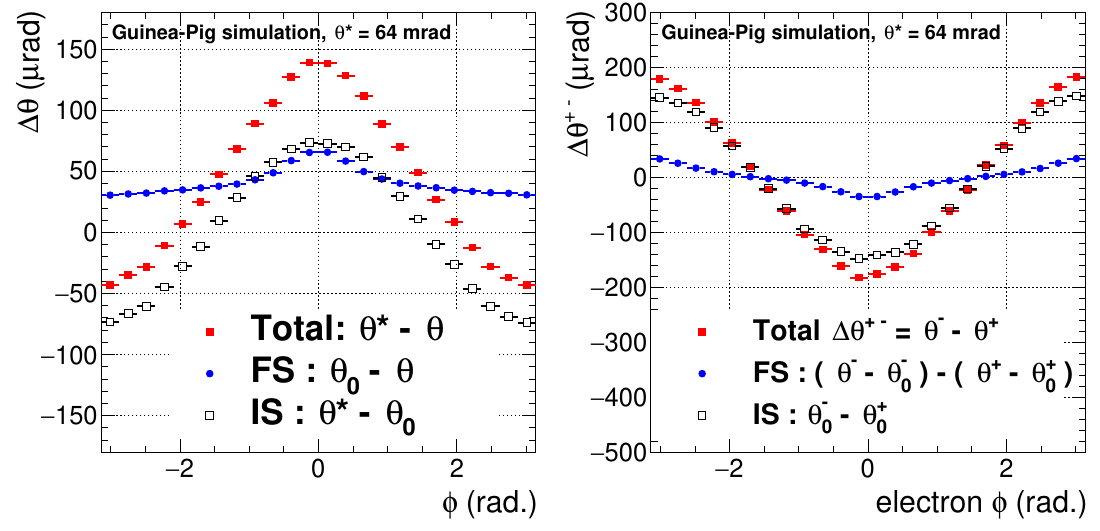
Figure 11 . Left: Angular focusing of a 45 : 6 GeV e (cid:6) emitted at an angle of 64 mrad as a function of its azimuthal angle. The combined e(cid:11)ect of the p kick acquired by the initial state (IS, black x open squares) and of the focusing of the (cid:12)nal state (FS) lepton as it emerges from the interaction (blue closed dots) is shown as the red closed squares. Right: Acollinearity of the (cid:12)nal state of a Bhabha event, de(cid:12)ned as the di(cid:11)erence (cid:18) (cid:0) (cid:0) (cid:18) + where (cid:18) (cid:0) ( (cid:18) + ) denotes the polar angle of the e (cid:0) (e + ) with respect to the electron (positron) beam direction, as a function of the azimuthal angle of the electron. The acollinearities induced by the initial state and by the (cid:12)nal state e(cid:11)ects are also shown